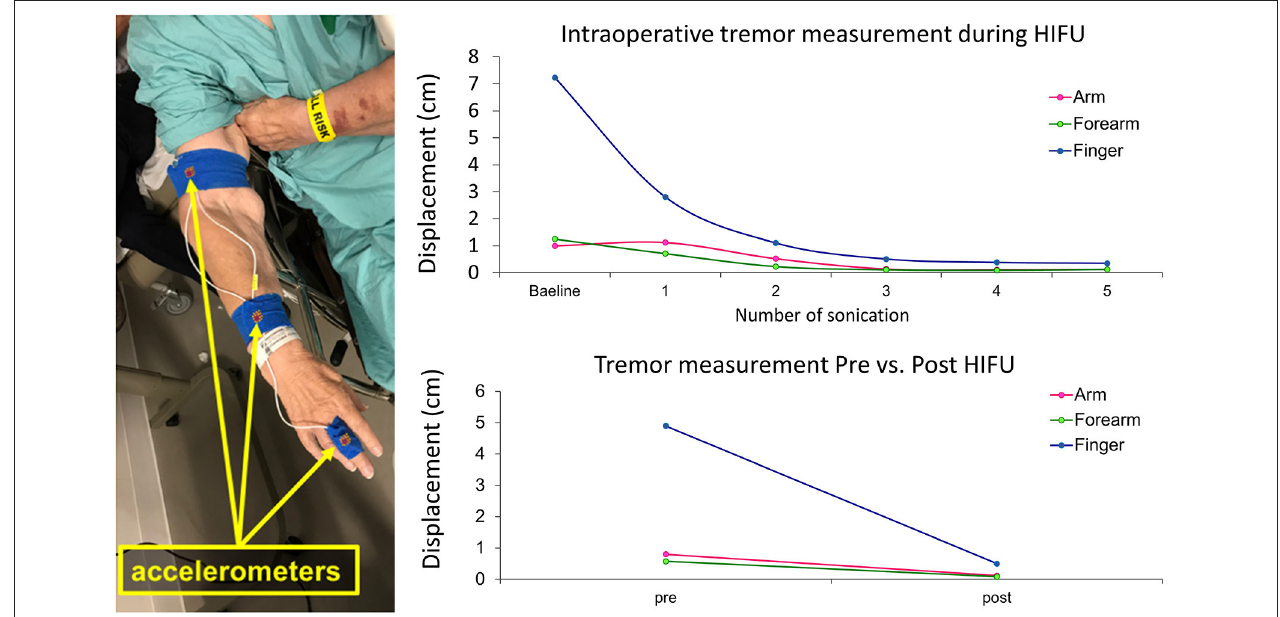
FIGURE 7 | Intraoperative monitoring of treatment response using accelerometer recordings. Accelerometer sensors are placed on the patient’s finger, forearm, and upper arm during MRgFUS thalamotomy. With the patient in the MR machine, displacements of the finger, forearm, and upper arm during tremor are plotted after each sonication measure (upper graph). With the patient sitting upright in the preparation room, postural tremor is measured before and after the thalamotomy procedure (lower